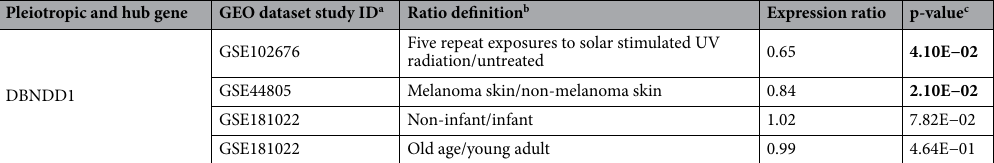
Table 5. Differentially expressed pleiotropic and hub genes associated with UV radiation exposure. a GSE181022 controls for sun exposure by using only Sun-protected skin. The skin tissue in GSE85358 is skin aged normally, which will typically be exposed concurrently to numerous factors (e.g., chronological age and sun exposure). b The expression ratio is the average expression level in the aged tissue or tissue with skin ageing phenotypes (i.e., cases) divided by (/) the average expression level in the young tissue or tissue without skin ageing phenotypes (i.e., reference). Ratios above 1 indicate higher expression levels in the cases group while ratios below 1 indicate lower expression levels in the cases group. c Significant values (p-Value < 0.05) are